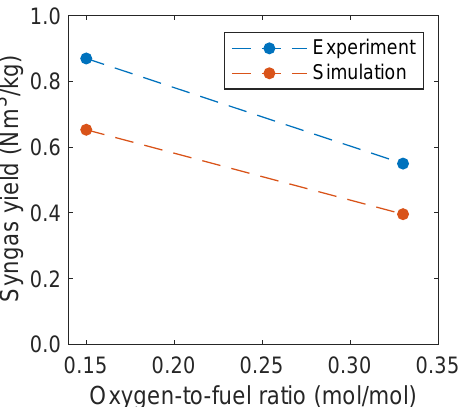
Figure 14. Syngas yield as a function of the oxidation degree in comparison with experimental data given by Condori et al.